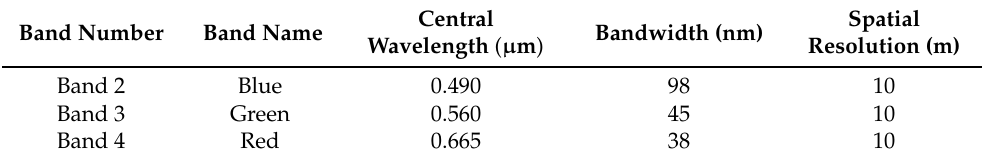
Table 1. Sentinel-2A bands used in